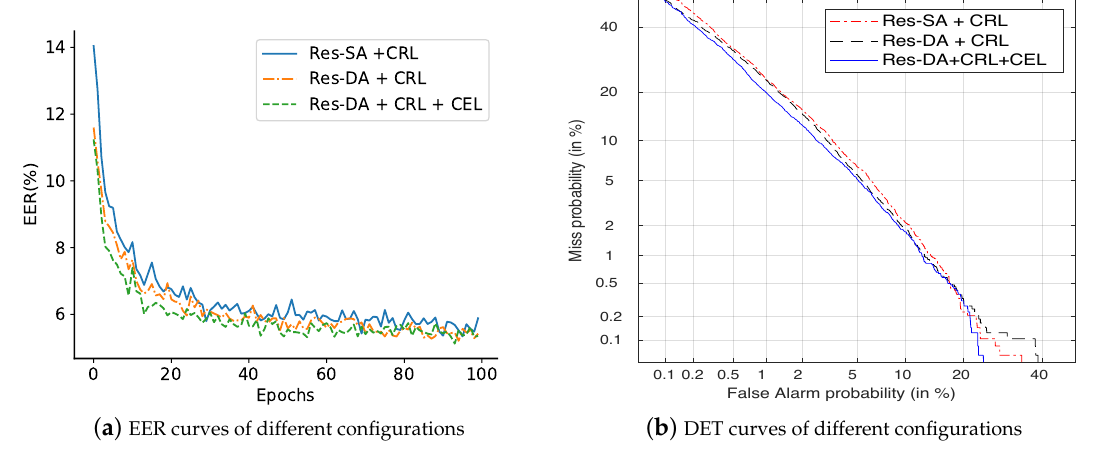
Figure 8. Metric curves for speaker verification. EER, Equal Error Rate; DET, Detection Error